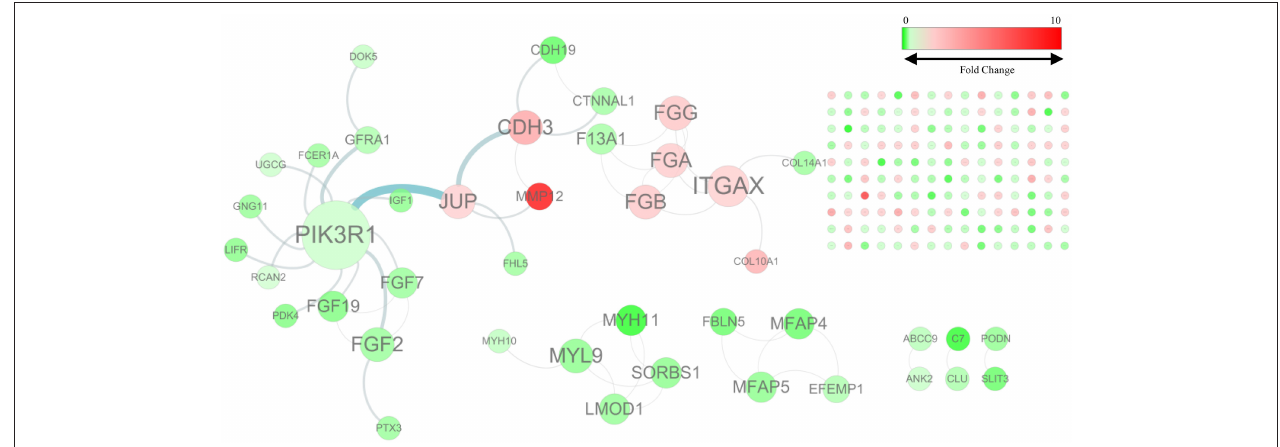
FIGURE 1 | The functional interaction (FI) network constructed using GBC-related differentially expressed genes. Edges are based on FI annotation. Node sizes represent degree value of the FI network, ranging from 0 to 12. Node colors define fold changes in GBC-related DEGs, ranging from red for high expression to green for low expression, relative to non-cancerous samples.